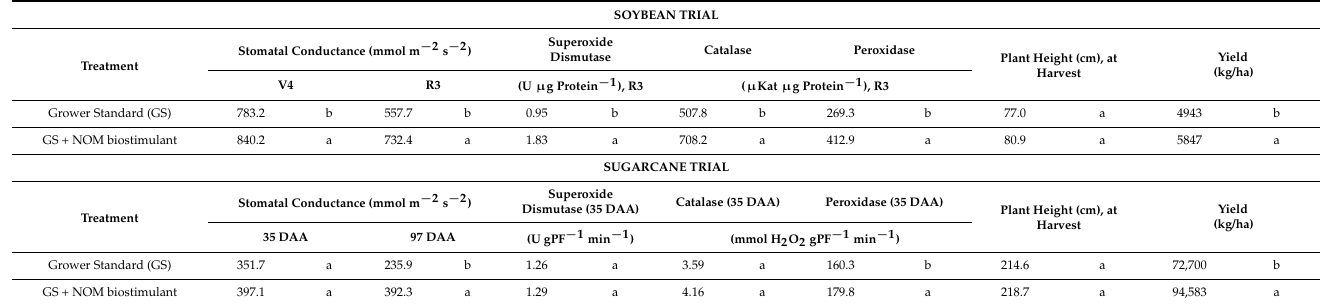
Table 3. Results for the soybean and sugarcane trials in Brazil for the grower standard (GS) plants and the GS + NOM-based biostimulant treated plants. Means with the same letter designation within each column do not differ significantly ( p = 0.10, least significant